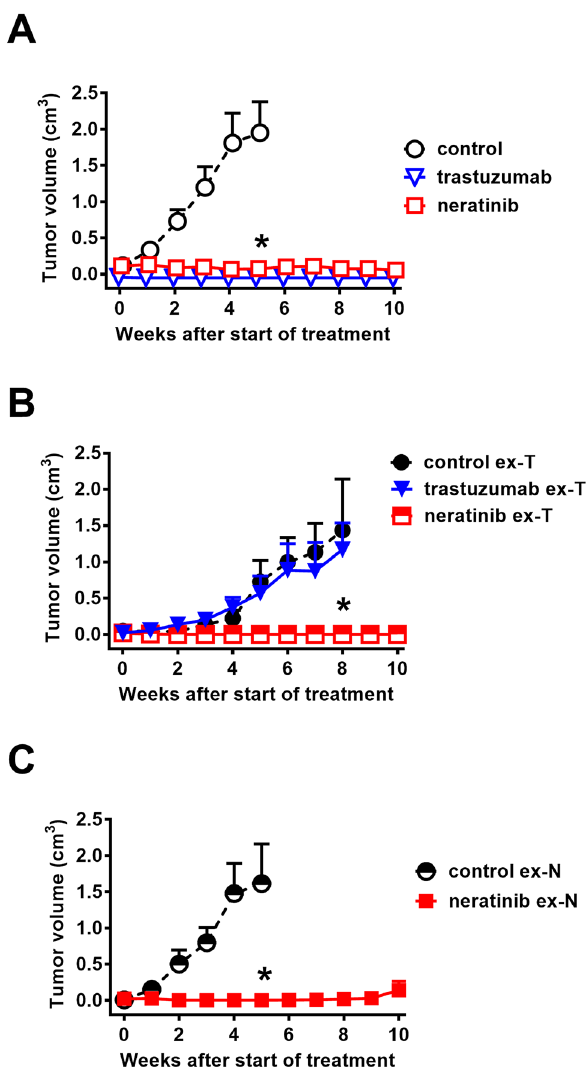
Figure 5. Resistance/sensitivity to different HER2-targeted treatments by PDX-BRB4 variants. ( A ) Sensitivity to HER2-targeted treatments of progressed PDX-BRB4-A1 subline (number of passages and mice per group: 21–27, n = 3–10). ( B ) PDX-BRB4 implants from xenografts chronically pre-treated with trastuzumab (ex-T) are still responsive to neratinib (number of passages and mice per group: 6–10, n = 4). ( C ) PDX-BRB4-A1 implants deriving from xenografts chronically pre-treated with neratinib (ex-N) are still responsive to neratinib (number of passages and mice per group: 22–23, n = 4). Significance versus control: *p <